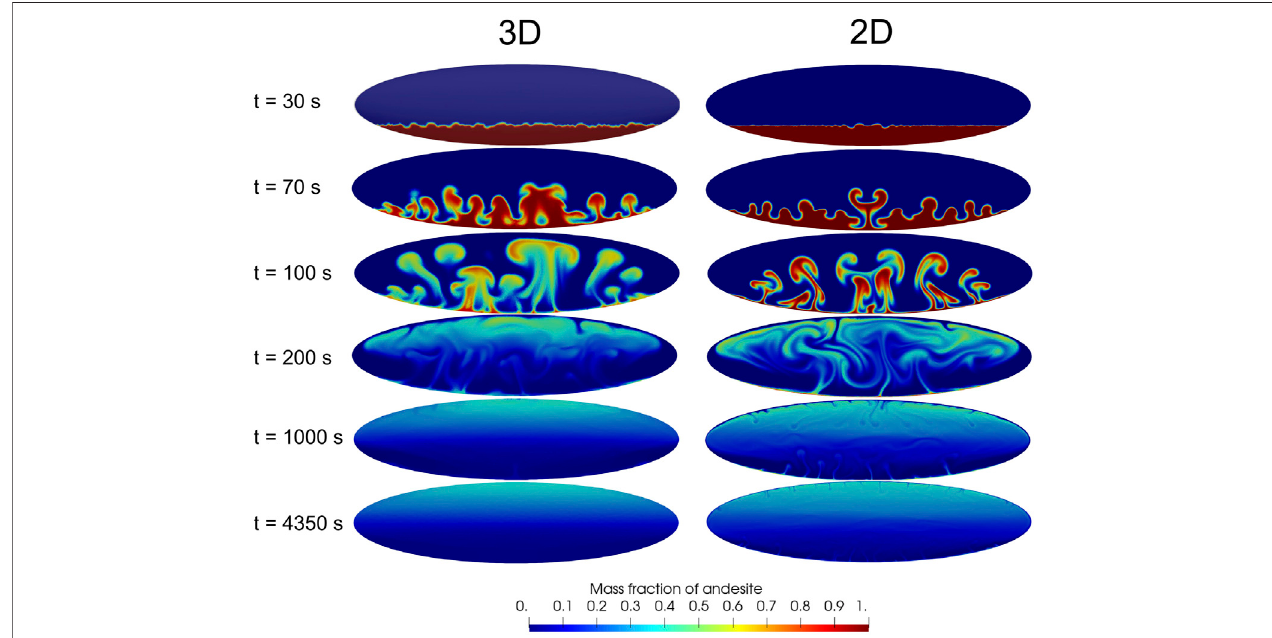
FIGURE 8 | Comparison between 2D simulation and a vertical slice at z (cid:2) 0 from the 3D simulation #1.